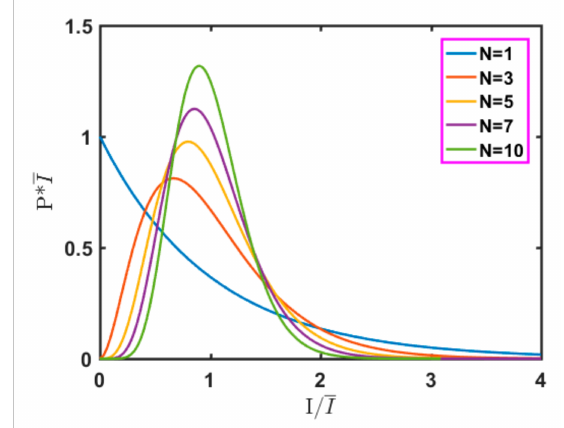
Figure 2. Probability density function of the sum of N independent equal-intensity speckle patterns.